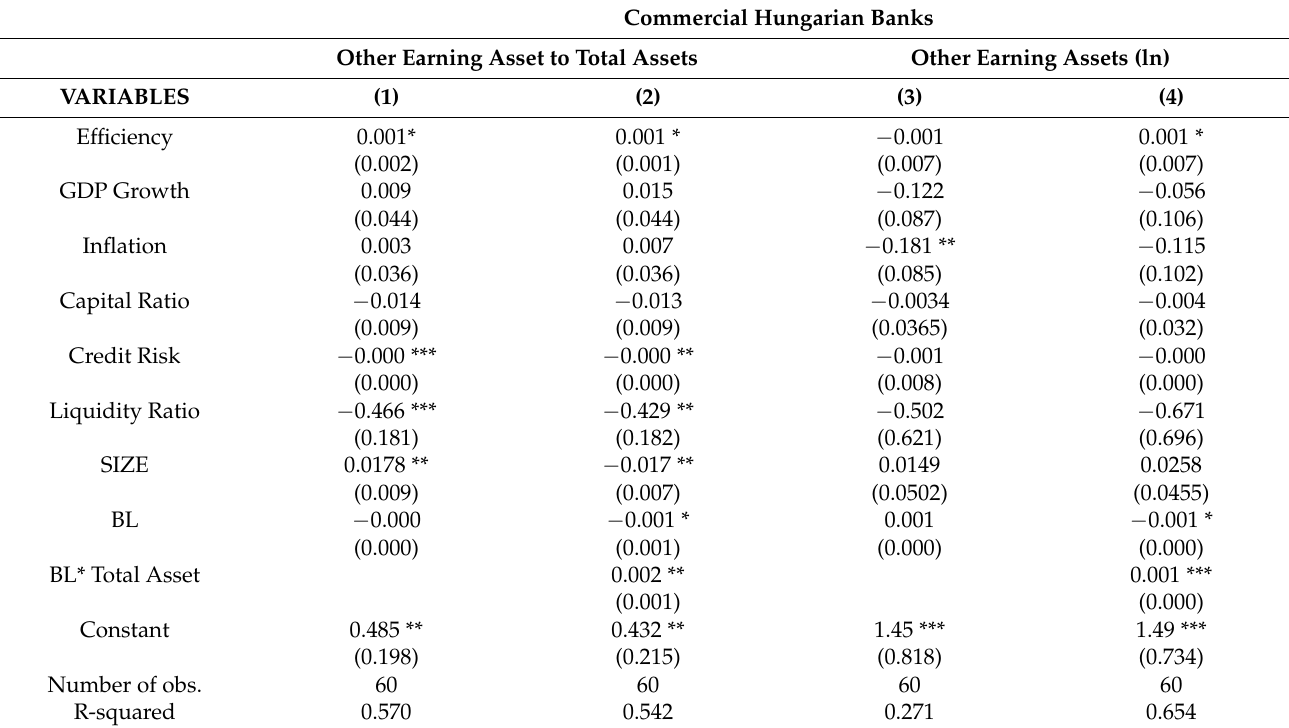
Table 5. Data presenting estimates based on GLS regressions with a random effect on Hungarian commercial banks. Symbols *, **, and *** represent statistical significance at the levels of 10%, 5%, and 1%,